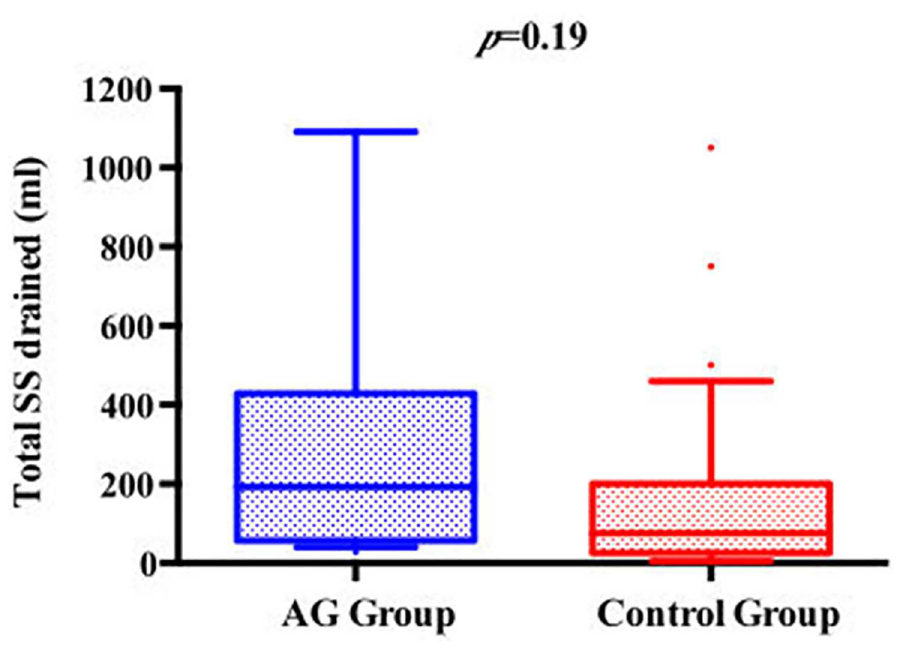
Fig 2. Comparison between AG group and control group according to total SS